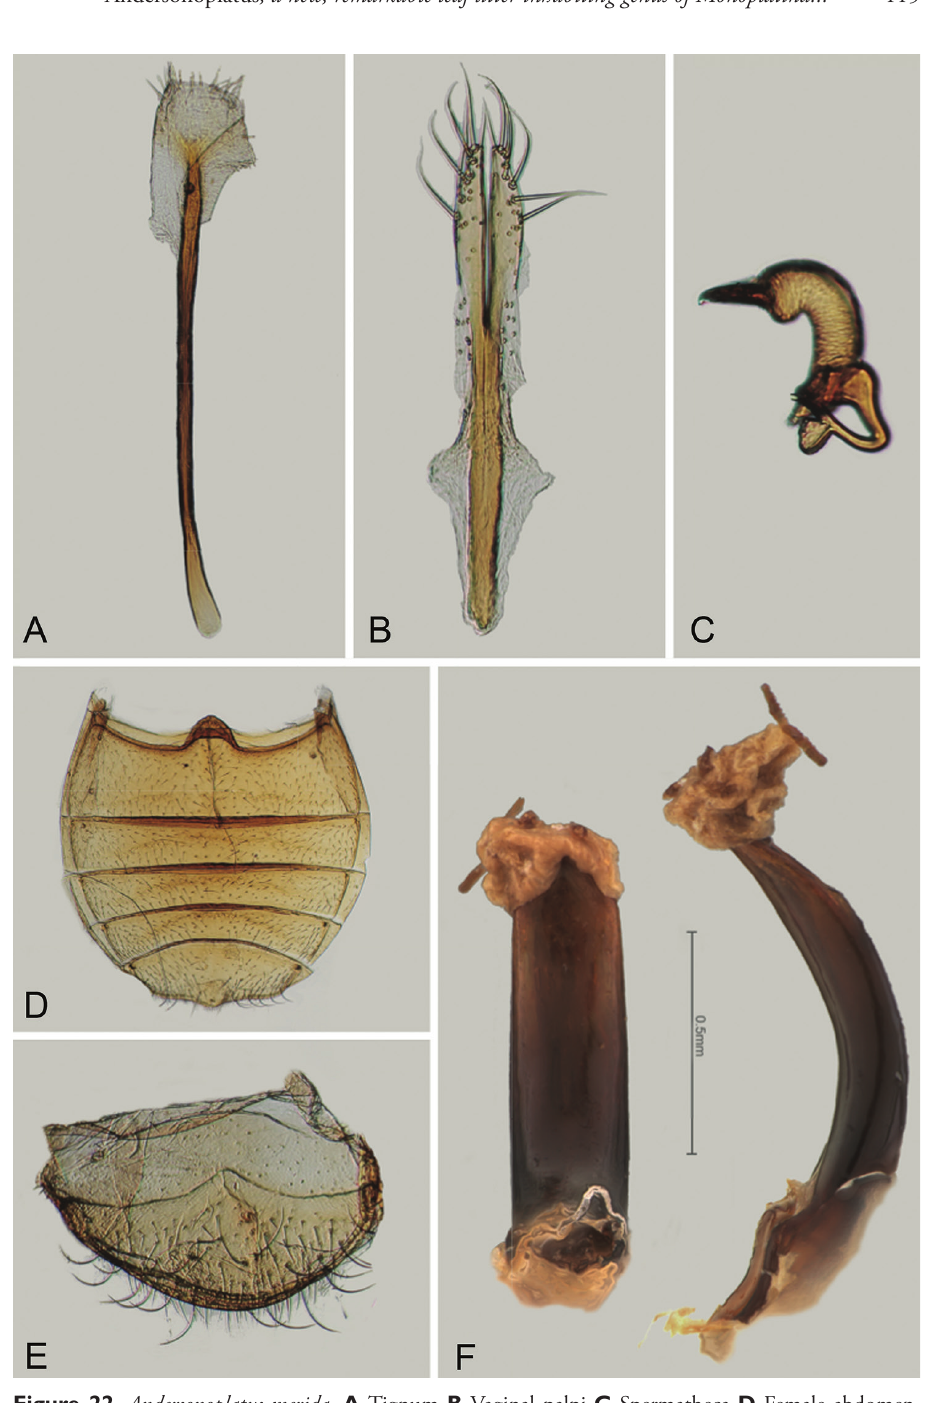
Figure 22. Andersonoplatus merida . A Tignum B Vaginal palpi C Spermatheca D Female abdomen, ventral view E Last abdominal tergite of female F Median lobe of aedeagus, ventral and lateral